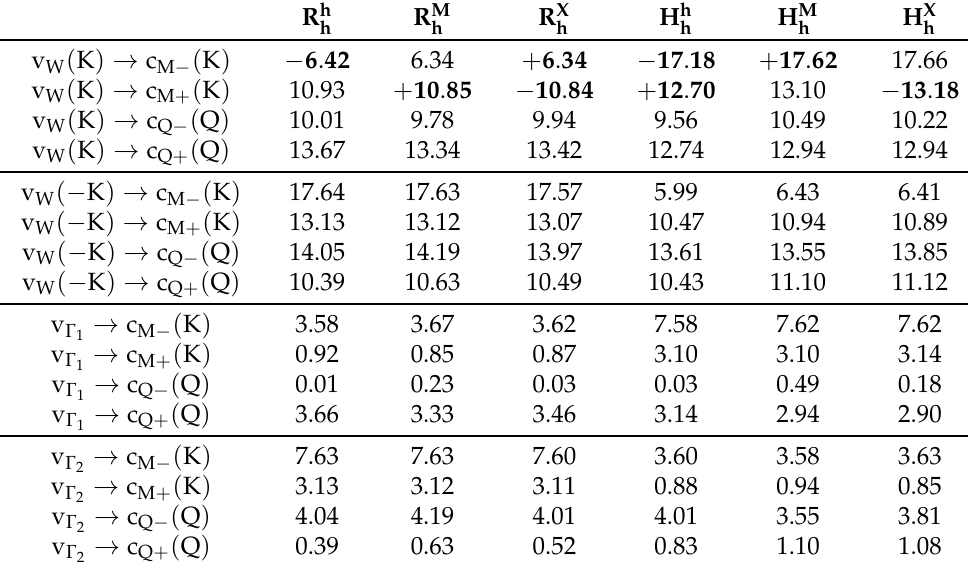
Table 8. Dipolar exciton g-factors involving the top valence band states (at Γ , K, and − K points) to conduction bands of Mo at the K point (c M ± ) or to the conduction bands at the Q point (c Q ± ) at zero electric field and equilibrium interlayer distance. The g-factors with unambiguously determined signs are given in